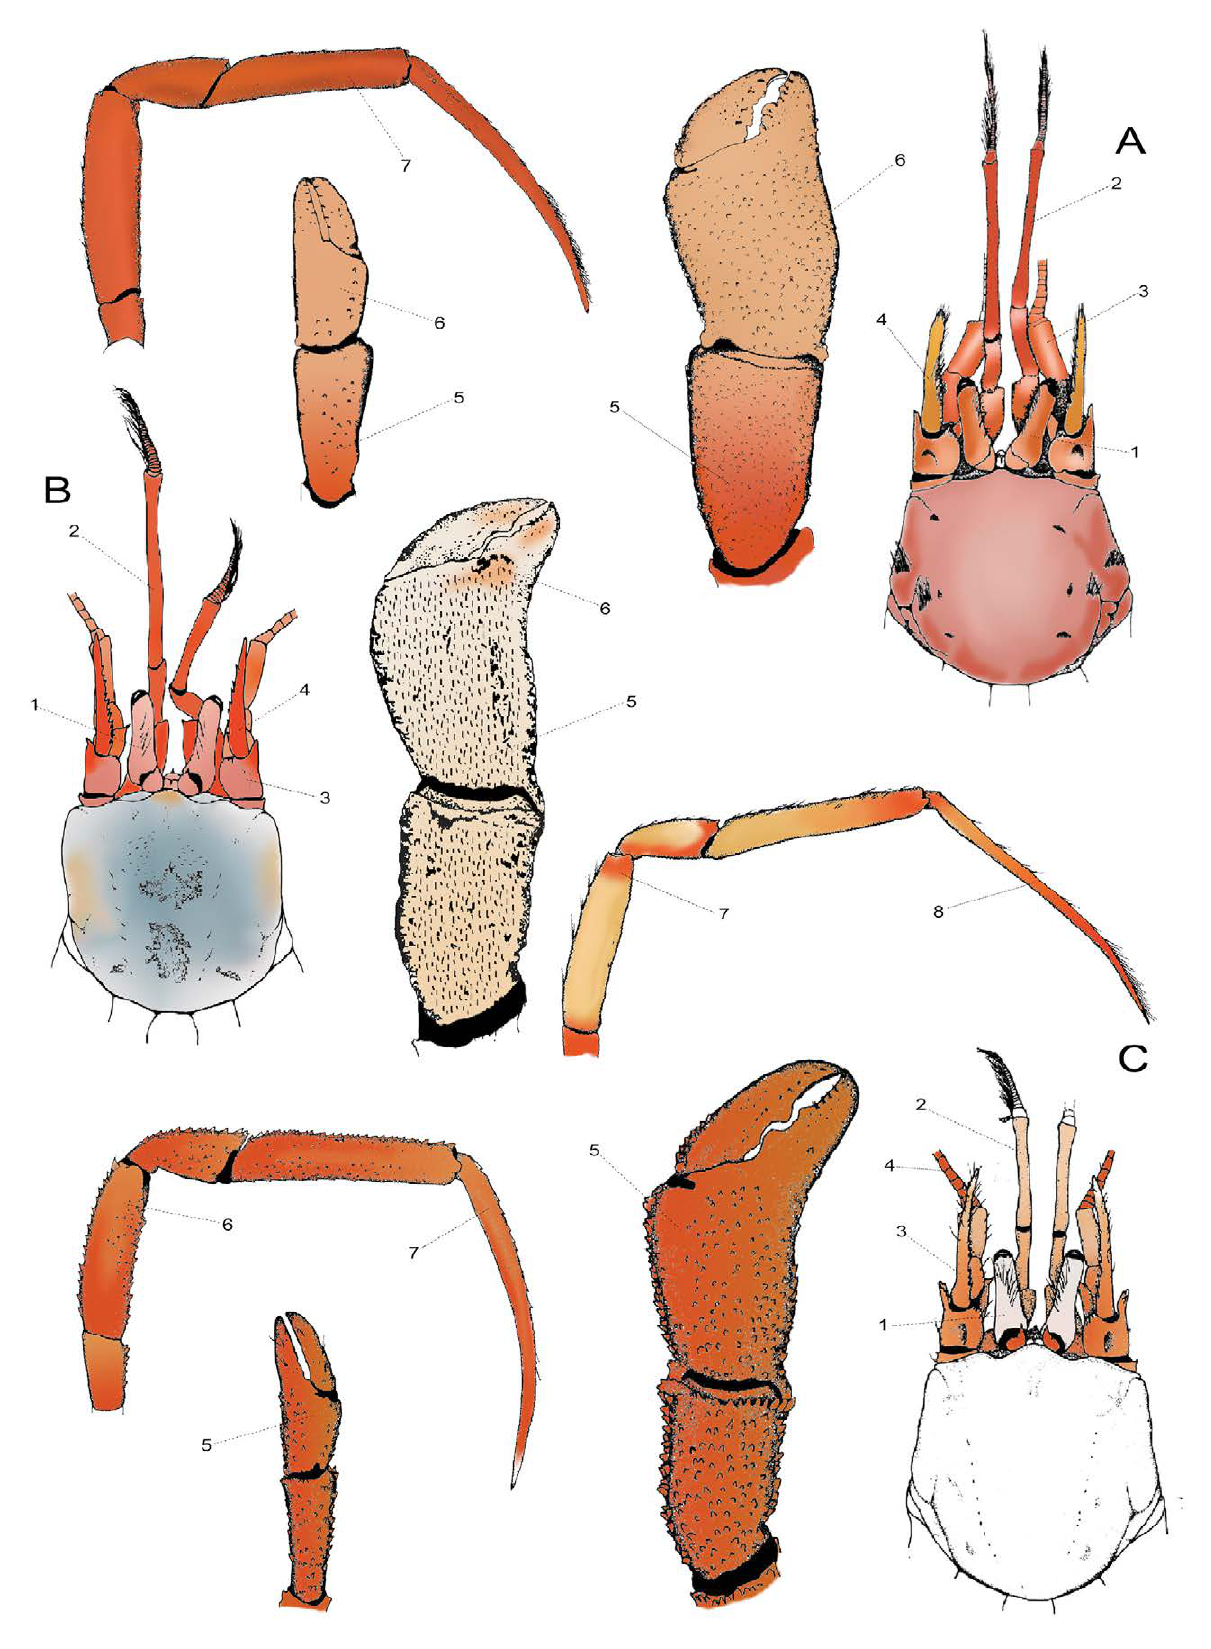
Fig. 13. – Colour patterns of Parapagurus species: P. pilosimanus (A, 1-7); P. alaminos (B, 1-8); P. abyssorum (C, 1-7). All vectorial drawings modified from Lemaitre